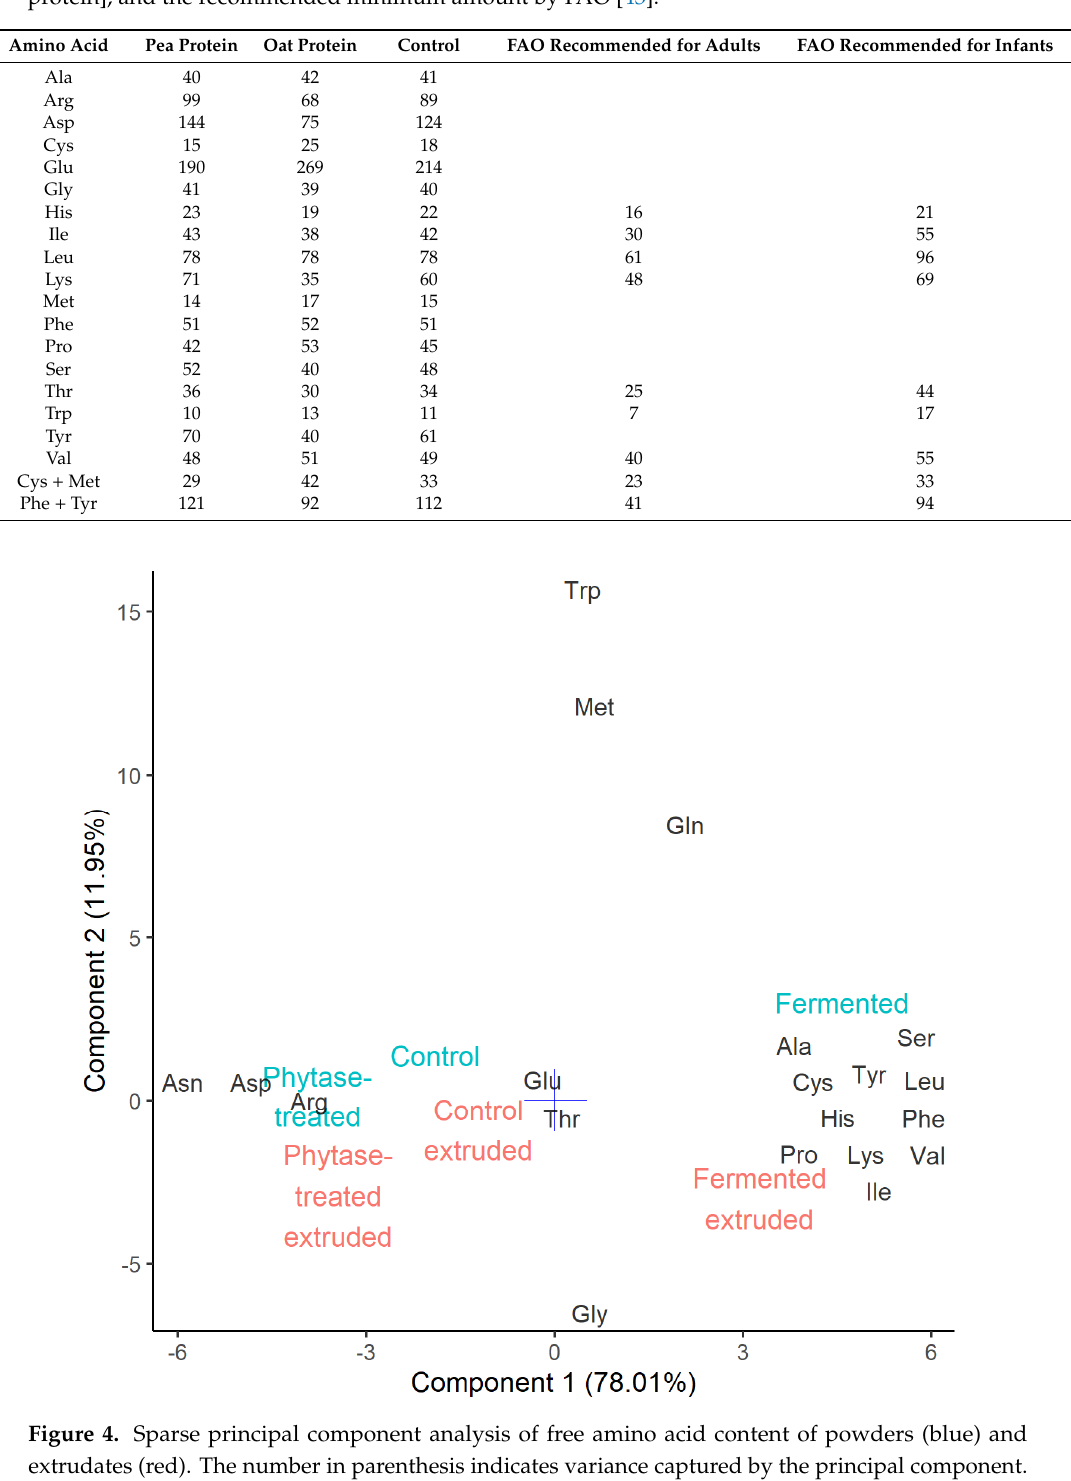
Table 7. Total amino acid content of pea protein isolate, oat protein concentrate, control blend [mg g − 1 protein], and the recommended minimum amount by FAO [43].